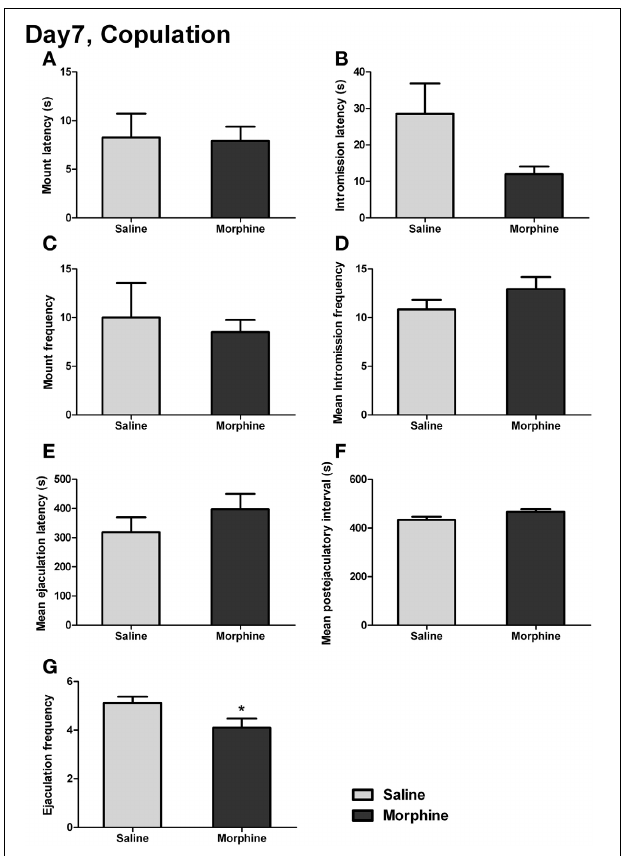
FIGURE 7 | The effects of morphine withdrawal on different copulatory measures in male rats. The copulation testing was performed on day 7 of withdrawal. (A) Latency to first mount. (B) Latency to first intromission. (C) Number of mounts before the first ejaculation. (D) Mean number of intromissions prior to each ejaculation. (E) The mean of ejaculation latencies. (F) The mean of PEIs. (G) Total number of ejaculations. ∗ P < 0 . 05, relative to saline group. Values are mean ± s.e.m.